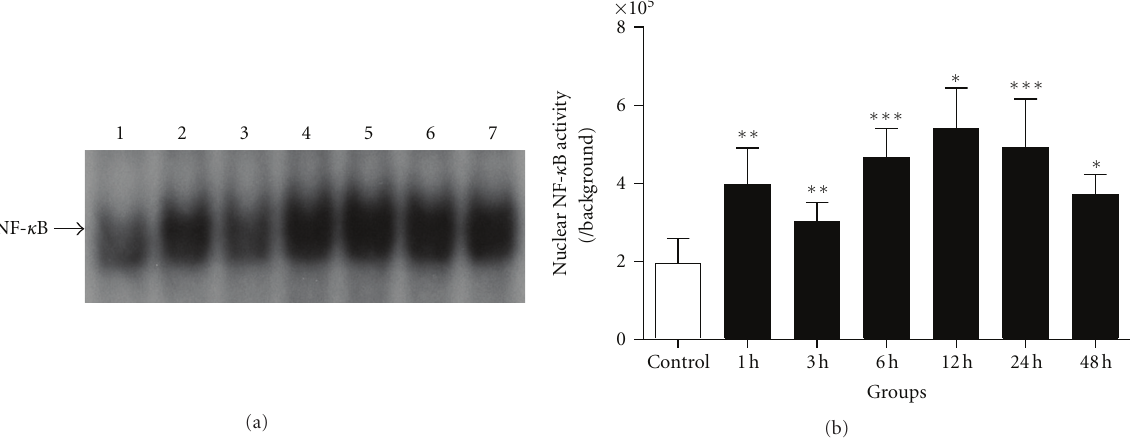
Figure 2: NF- κ B activity in Hb-incubated neurons was determined by EMSA in control, 1 h, 3h, 6h, 12h, 24 h, and 48 h groups (lanes 1, 2, 3, 4, 5, 6, and 7 in (a) resp.; n = 6 per group). NF- κ B activity in cultured neurons was significantly increased after incubated with Hb ( P < 0 . 05). The NF- κ B activity showed the double peaks in 1h and 12h groups, ∗ P < 0 . 05, ∗∗ P < 0 . 01, and ∗∗∗ P < 0 . 001 versus control group. Bars represent the mean ±